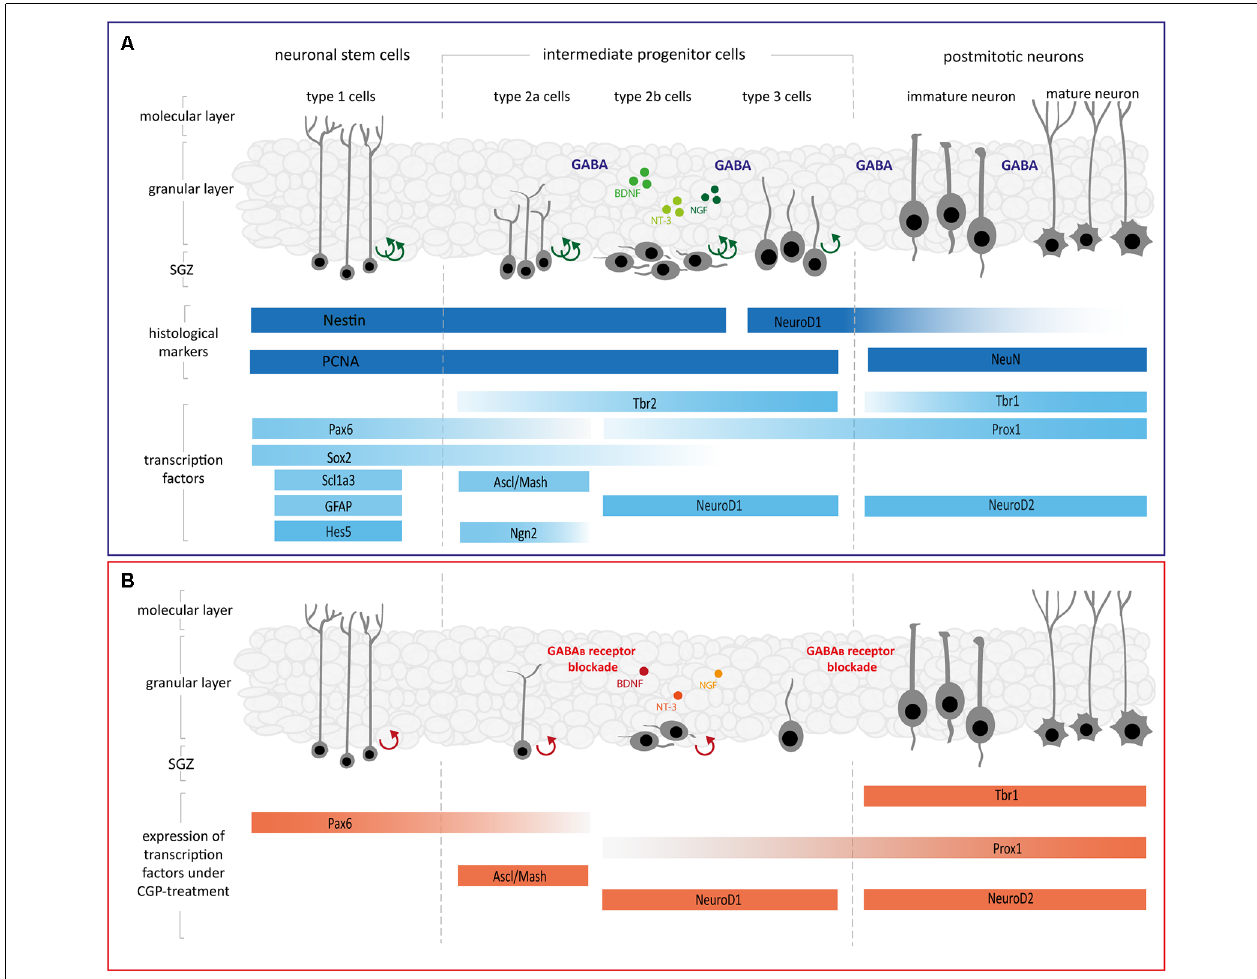
FIGURE 5 | (A) Schematic diagram illustrating the different phases of neurogenesis in the DG. Asymmetrically dividing neuronal stem cells situated at the subgranular zone (SGZ) of the DG give rise to intermediate progenitor cells type-2a, type-2b, and type-3, which are highly proliferative, and their progeny determined for neuronal fate. Following further differentiation, intermediate progenitors extend processes, mature, exit the cell cycle and finally differentiate into mature neurons. Most of the regulators play an important role in self-renewal, proliferation, and fate specification during neurogenesis (see main text for details, modeled after Roybon et al., 2009; Lugert et al., 2010; Berg et al., 2018; Vieira et al., 2018; Hevner, 2019). (B) Schematic diagram depicting how the GABA B receptor blockade changes single steps of hippocampal neurogenesis. GABA B receptor blockade with CGP led to reductions in proliferating Nestin+ as well as NeuroD1+ cells, furthermore, expression of Pax6, Ascl1, NeuroD1, Tbr1, Prox1 , and NeuroD2 was decreased (see main text for details, modeled after Roybon et al., 2009; Lugert et al., 2010; Berg et al., 2018; Vieira et al., 2018; Hevner, 2019). Abbreviations: Ascl1, achaete-scute family bHLH transcription factor 1; BDNF, brain-derived neurotrophic factor; CycD2, cyclin D2; GABA, γ -aminobutyric acid; GFAP, glial fibrillary acidic protein; Hes5, hairy-enhancer-of-split 5; NeuroD1/2, neurogenic differentiation 1/ 2; Ngn2, neurogenin 2; NGF, nerve growth factor; NT-3, neurotrophin 3; Pax6, paired box 6; Prox1, prospero homeobox 1; Sox2, SRY-box transcription factor 2;